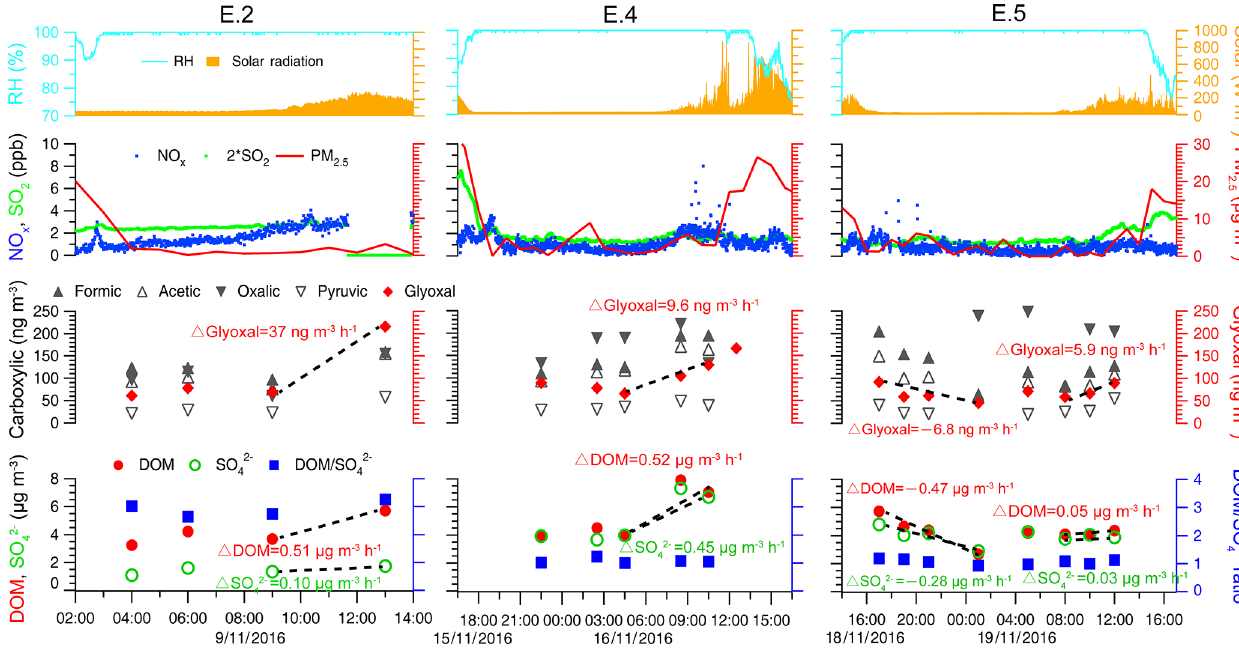
Figure 7. Temporal variation of air equivalent concentrations of glyoxal, carboxylic acids, dissolved organic matter, the SO 2 − DOM / SO 2 − ratio in cloud water, and ambient conditions during three cloud events (E.2, E.4, and E.5). Meteorological parameters (relative 4 humidity and solar radiation) and air pollutants (NO x , SO 2 , and PM 2 . 5 ) are also displayed. Mass change rates of cloud water components are indicated by dashed lines and